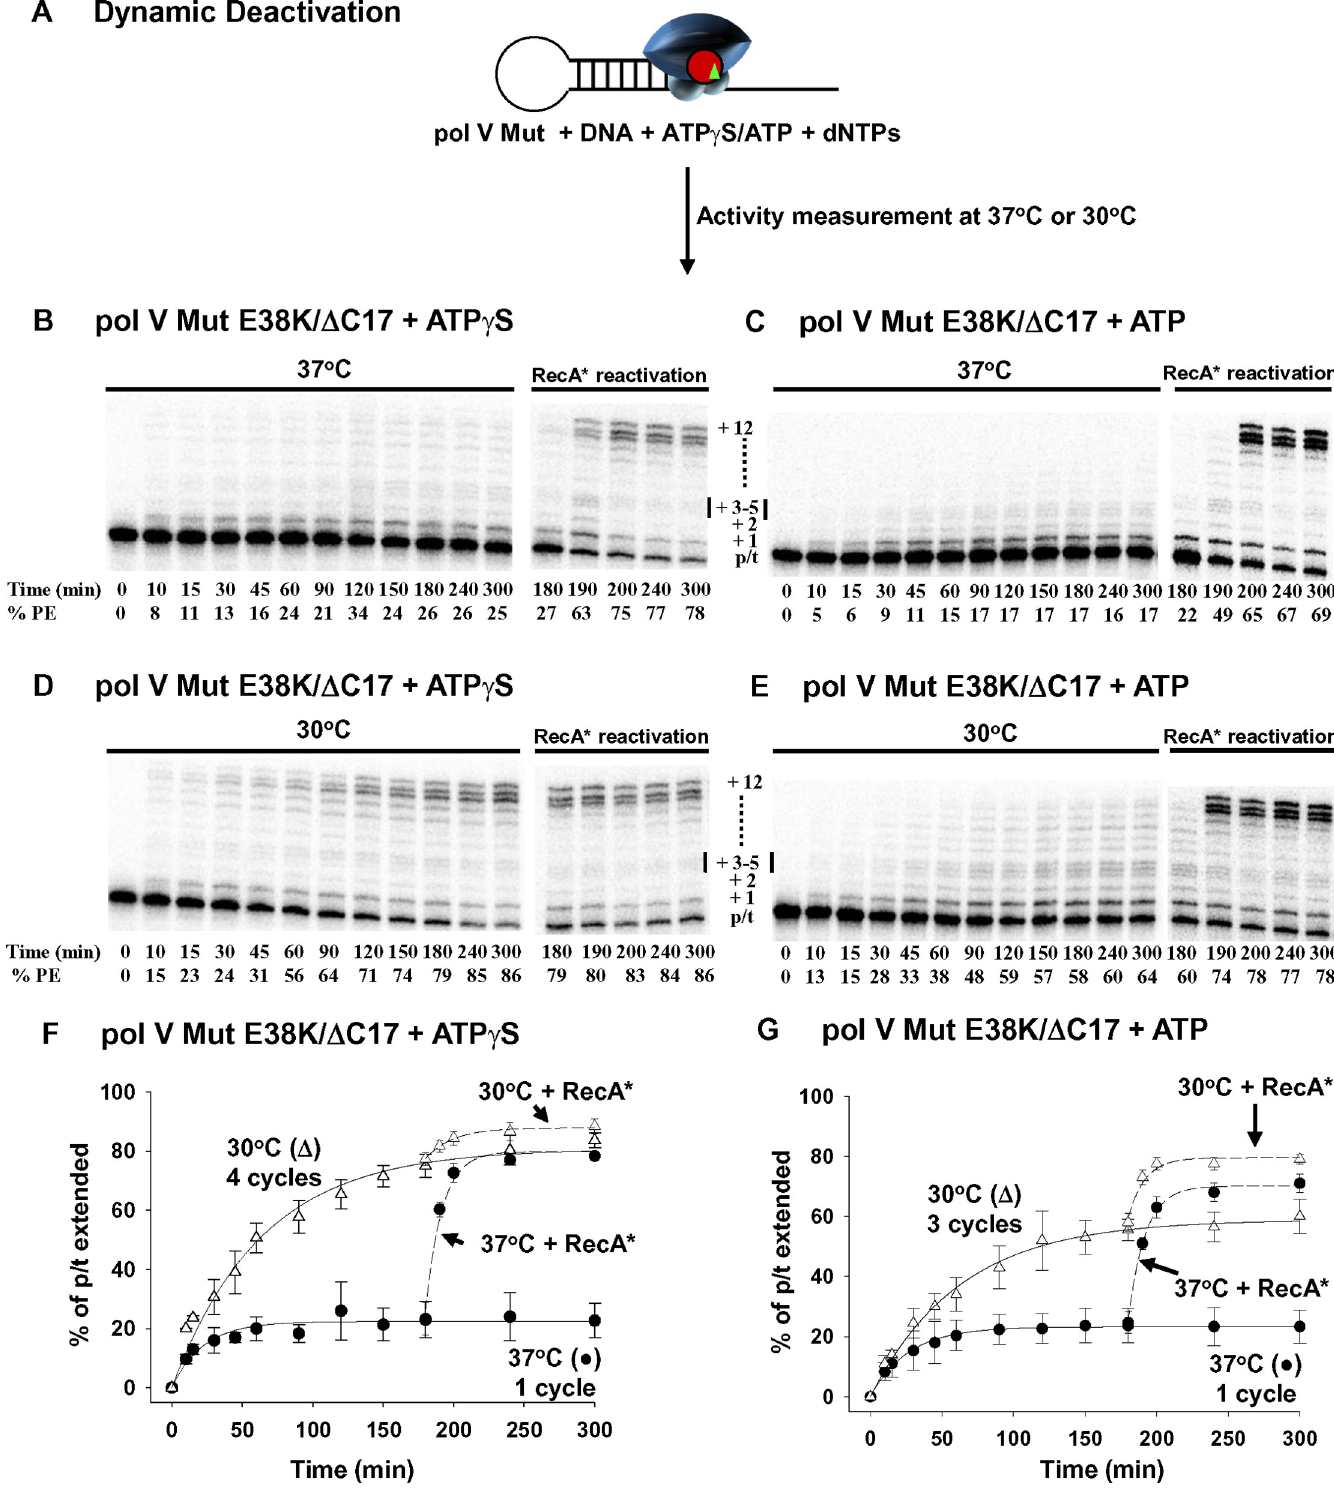
Fig 1. Temperature-dependent dynamic deactivation of pol V Mut E38K/ Δ C17. (A) Sketch showing dynamic deactivation of pol V Mut E38K/ Δ C17 (200 nM) with ATP γ S /ATP (500 μ M) at 37˚C and 30˚C in the presence of saturating concentration of dNTP’s (mix of dTTP, dCTP, dGTP 500 μ M each). Representative DNA synthesis gels for pol V Mut E38K/ Δ C17 with ATP/ATP γ S at 37˚C and 30˚C are presented in (B-E). Each experiment was repeated 3 times, and the average % PE